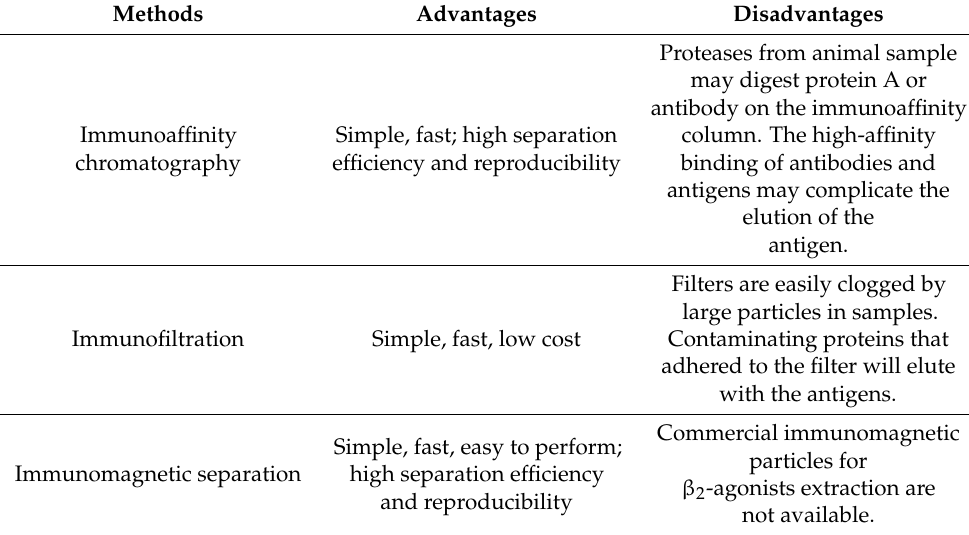
Table 1. Advantages and disadvantages of antibody-based methods for extracting β 2 -agonists from samples. Methods Advantages Disadvantages Proteases from animal sample may digest protein A or antibody on the immunoaffinity Immunoaffinity Simple, fast; high separation column. The high-affinity chromatography binding of antibodies and efficiency and reproducibility antigens may complicate the elution of the antigen. Filters are easily clogged by large particles in samples. Immunofiltration Simple, fast, low cost Contaminating proteins that adhered to the filter will elute with the antigens. Commercial immunomagnetic Simple, fast, easy to perform; particles Immunomagnetic separation high separation efficiency and reproducibility